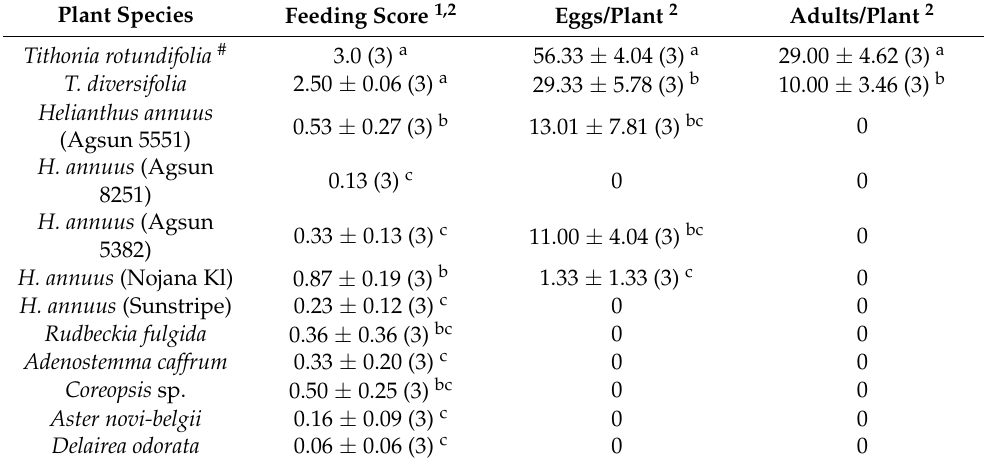
1 Feeding damage scores from 0 to 3: 0 = no feeding; 1= small feeding punctures (exploratory feeding); 2 = small feeding holes (restrained feeding); and 3 = large feeding holes (normal feeding). 2 Means followed by the same letters within columns did not differ significantly ( p > 0.05). Zero scores were excluded from statistical analysis. # Control/target weed species. Feeding damage by Z. signatipennis was rated as normal on the target weed ( T. rotundifolia ), restrained on T. diversifolia and exploratory on seven other plant species ( A. caffrum,